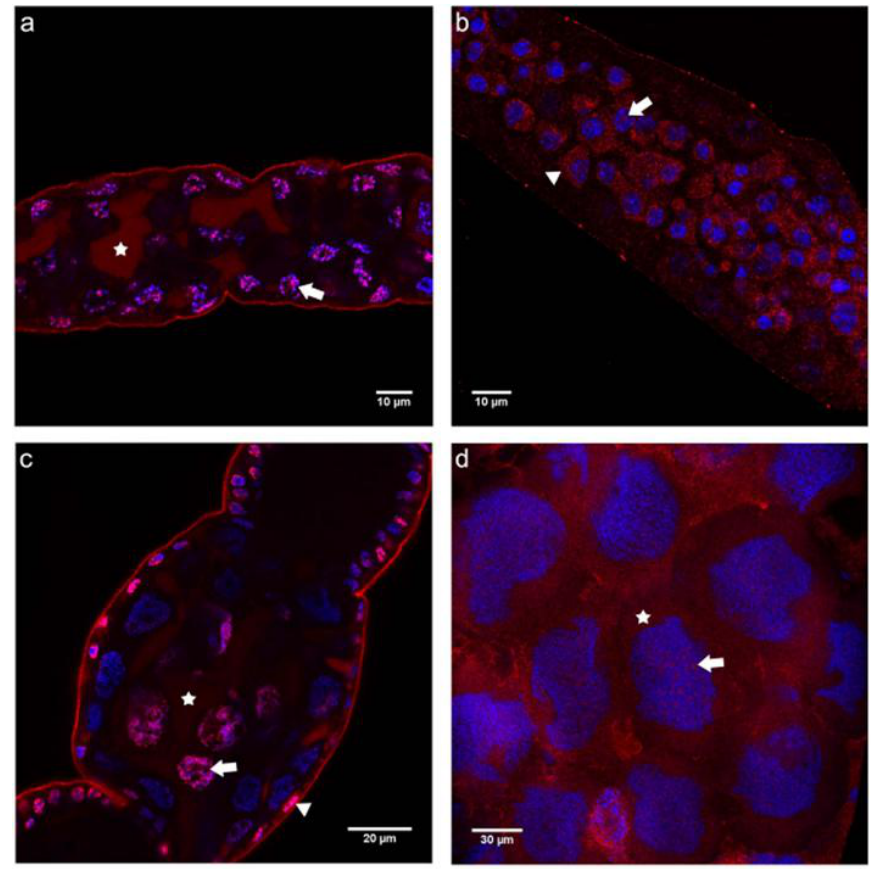
The E-cadC domain detected within nuclei as well as in association with cell boundaries in ovarioles of queens indicates that it may have both a cell adhesion function and a role in nuclear organization. A nuclear localization has already been described for vertebrate E-cadherin, this being stability of cellular adhesion by modulating a signaling pathway mediated by the